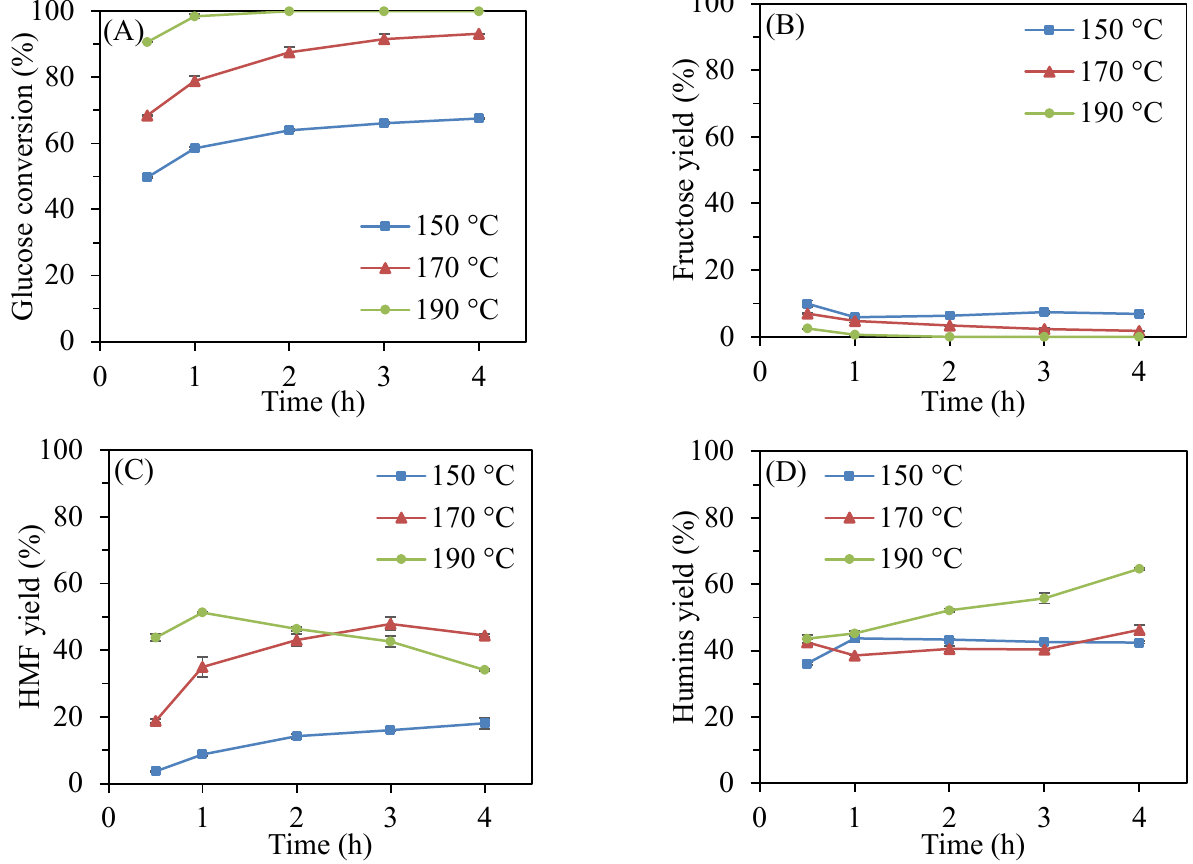
Figure 6. Effect of reaction temperature and time on ( A ) glucose conversion, ( B ) fructose yield, ( C ) HMF yield, and ( D ) humins yield using 10-Nb/MCS catalyst. (Reaction conditions: Catalyst amount, 0.1 g; glucose concentration, 0.07 M; solvent volume (1:2 v / v water saturated with NaCl: THF), 30 mL; N 2 pressure, 10 bar).